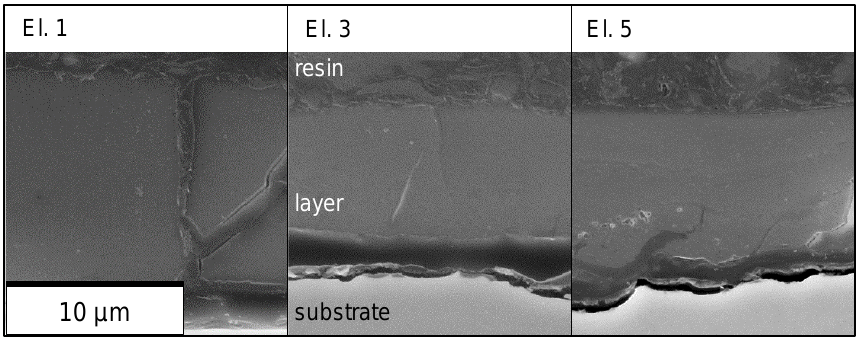
Figure 9. SEM images (SE contrast) of the cross-sections of samples that were polarized at constant OCP + 4 V in electrolytes 1, 3, and 5. The scale bar applies to all images. Table 3. Chemical compositions measured by EDX analyses at the cross-sections of samples that were polarized at constant potential (OCP + 4 V) in electrolytes 1, 3, and 5. Electrolyte Molar Fraction in % No. Al O P Fe 1 38.4 ± 0.8 61.4 ± 0.7 25.0 ±